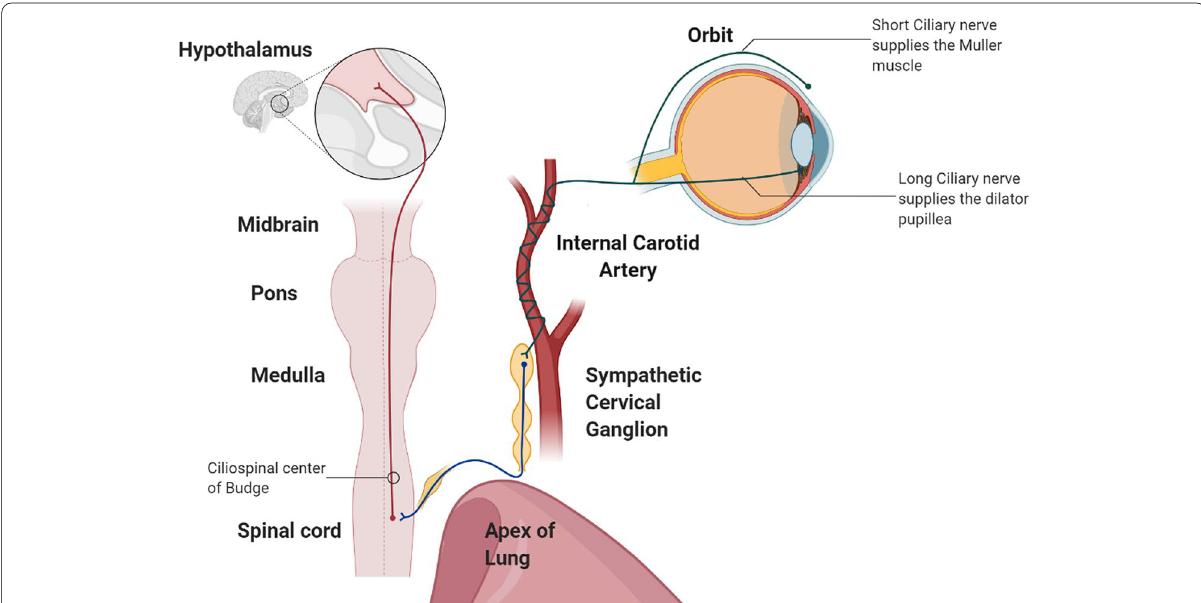
Fig. 2 Oculosympathetic pathway involved in Horner’s